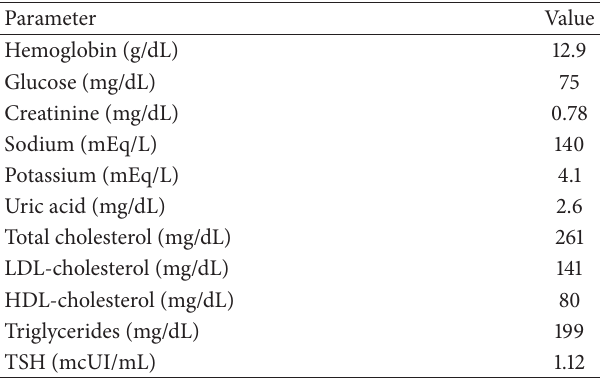
Table 1: Laboratorial